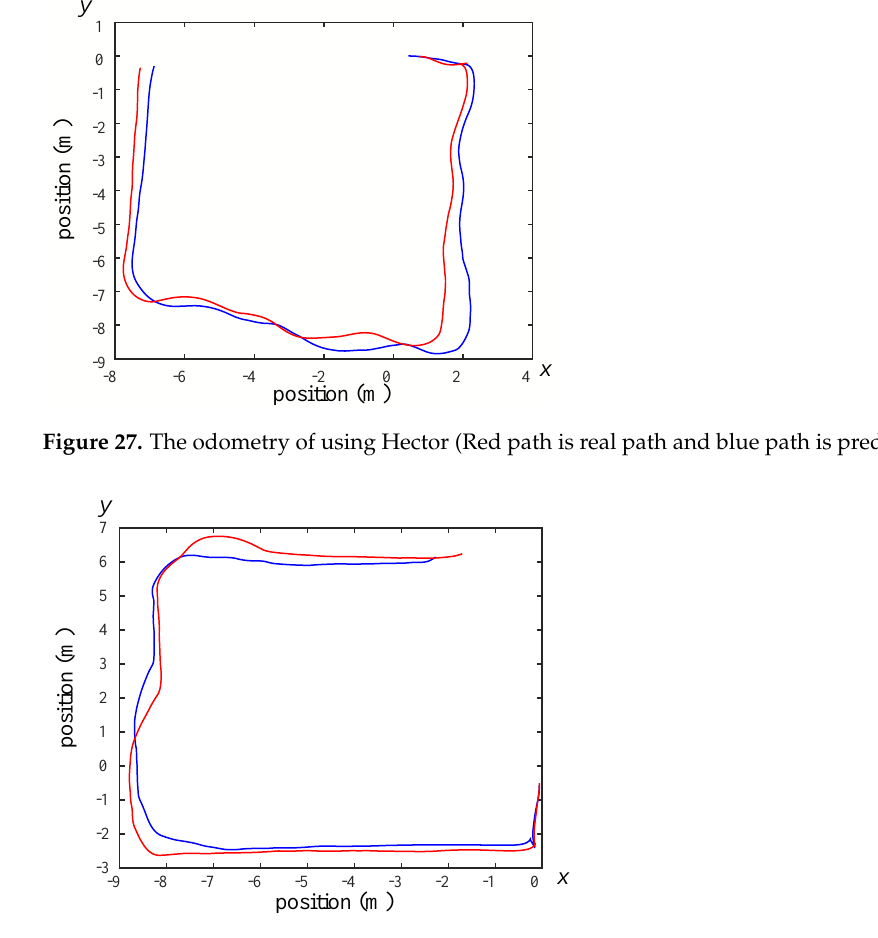
Figure 28. The odometry of using Cartographer (Red path is real path and blue path is predicted path)